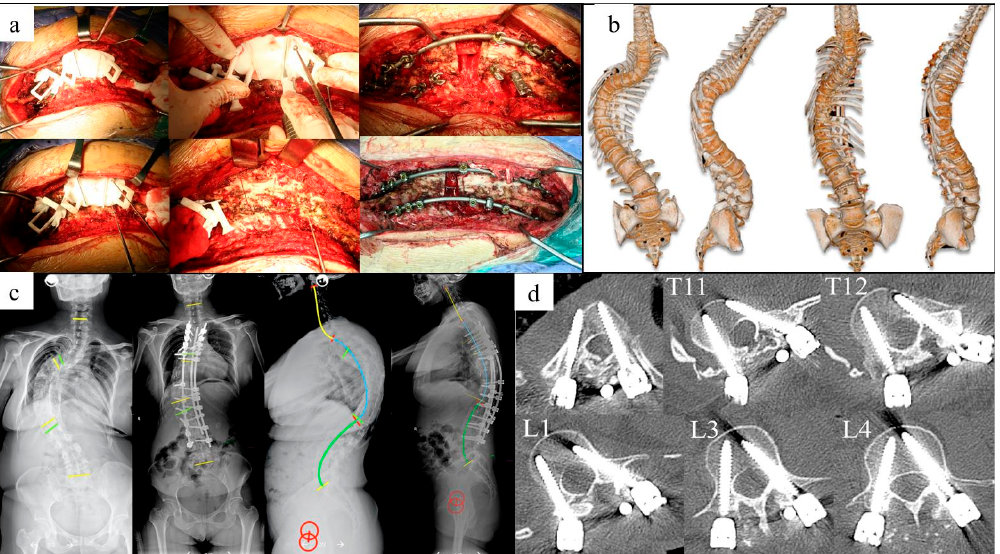
Figure 8. Surgical and radiological images for case 1. A 39-year-old female patient had a previous history of spinal correction surgery 26 years ago, and was given T10 VCR osteotomy and T3-L4 fixation and fusion, utilizing the personalized surgical simulation and 3DP guidance templates. ( a ) Surgery procedure of osteotomy and correction; ( b ) three-dimensional spine construction pre- and post-operation; ( c ) radiological images show great improvement of deformity between pre- and post- operation; ( d ) screw insertion accuracy in thoracic and lumbar